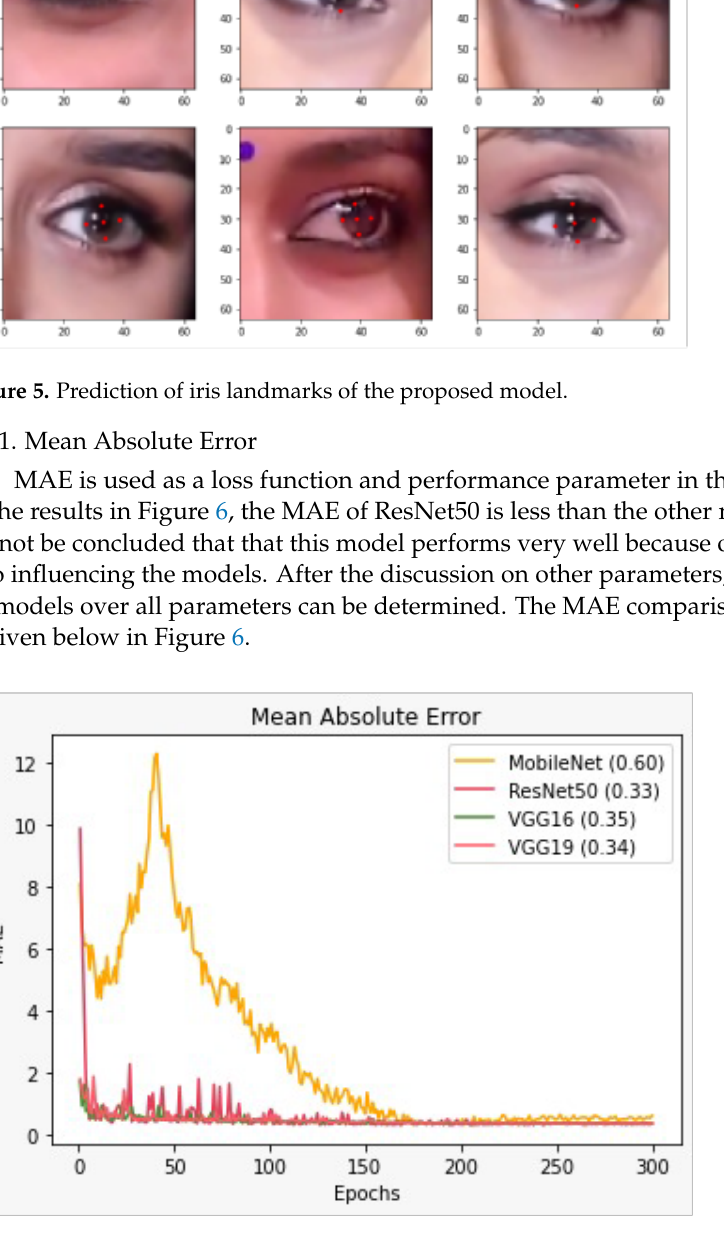
Figure 6. Mean Absolute Error of all the